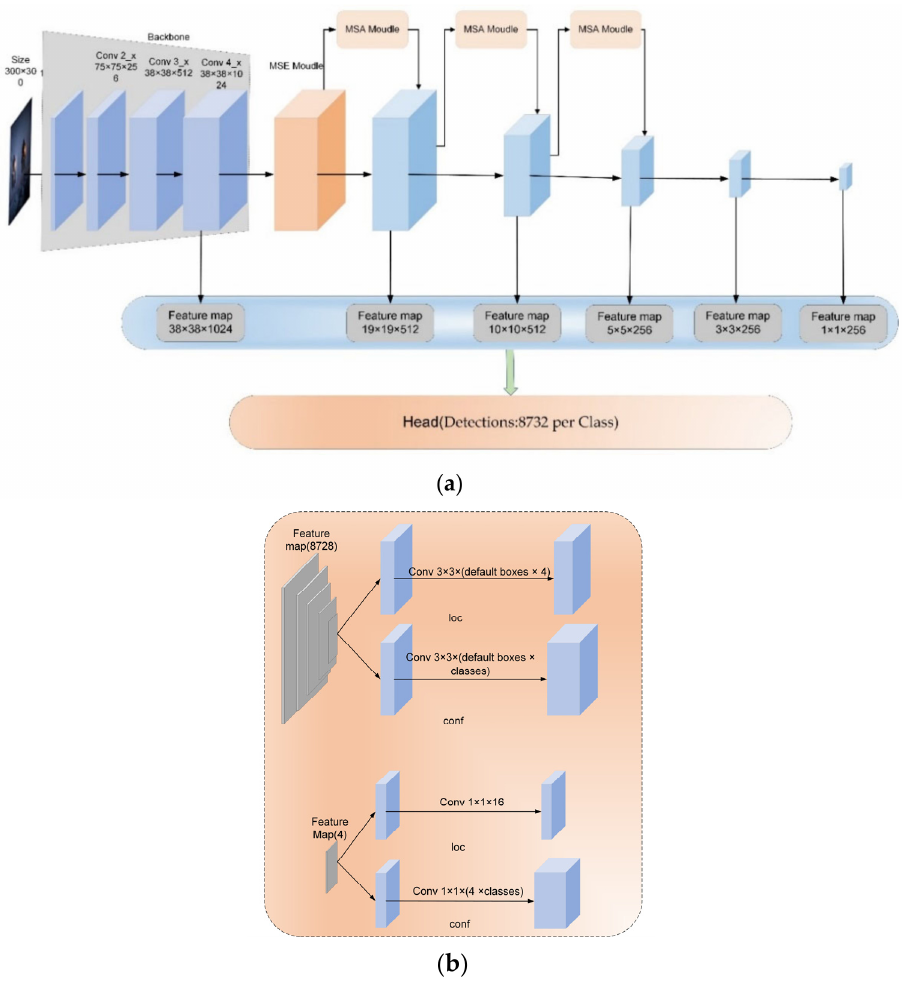
Figure 7. ( a ) Improved target detection framework. ( b ) Objective classification network with regression network (prediction head).